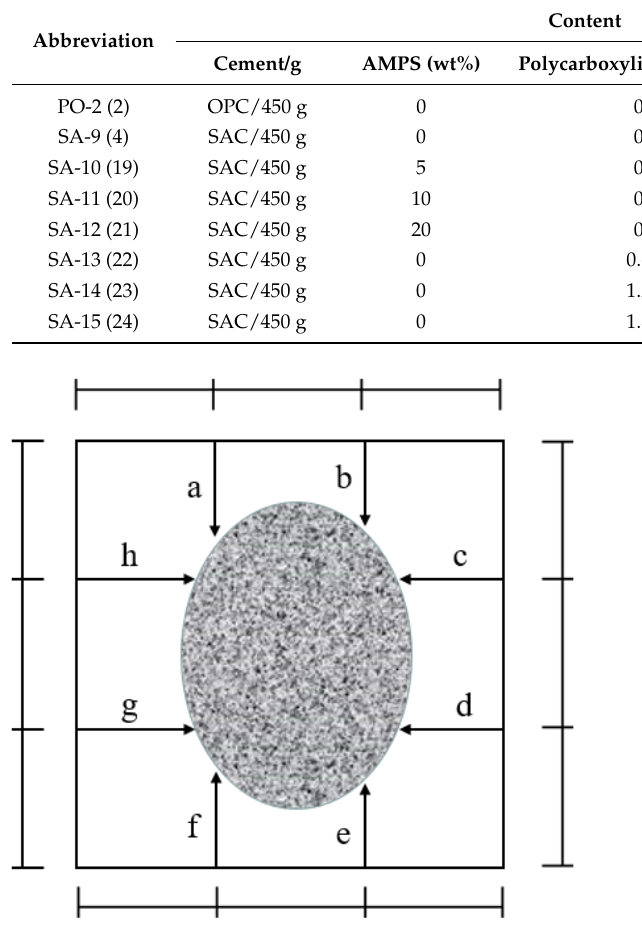
Figure 3. Measurement method of carbonation depth.